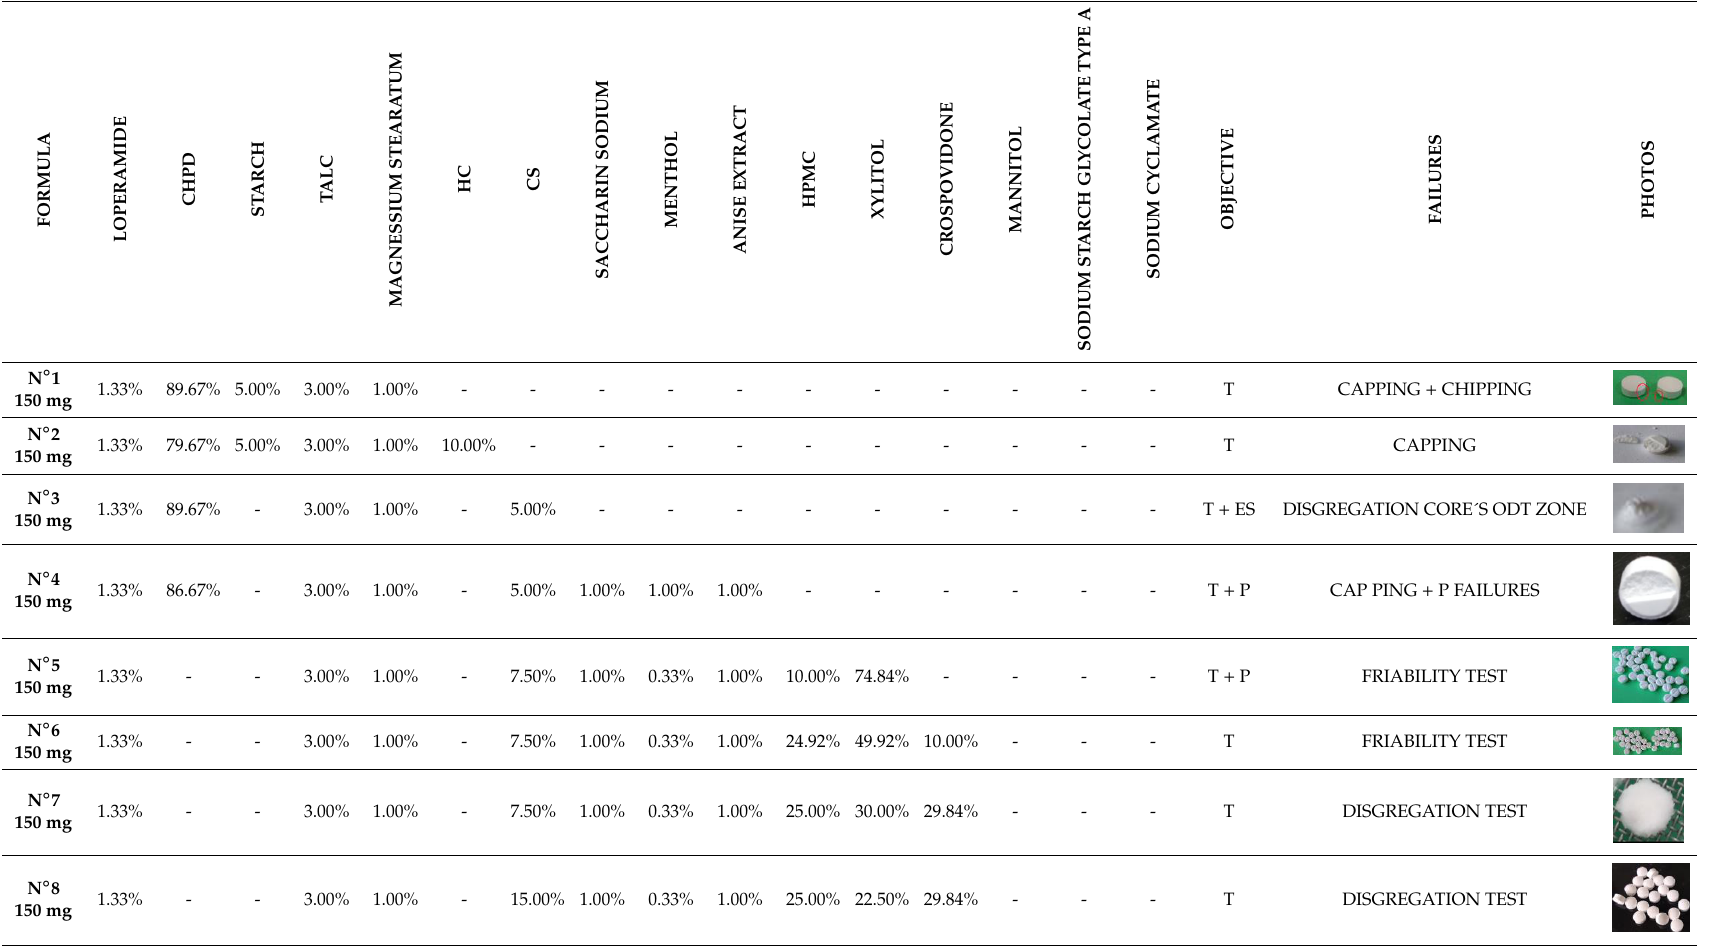
Table 1. Compositions of the investigated tablet formulations.